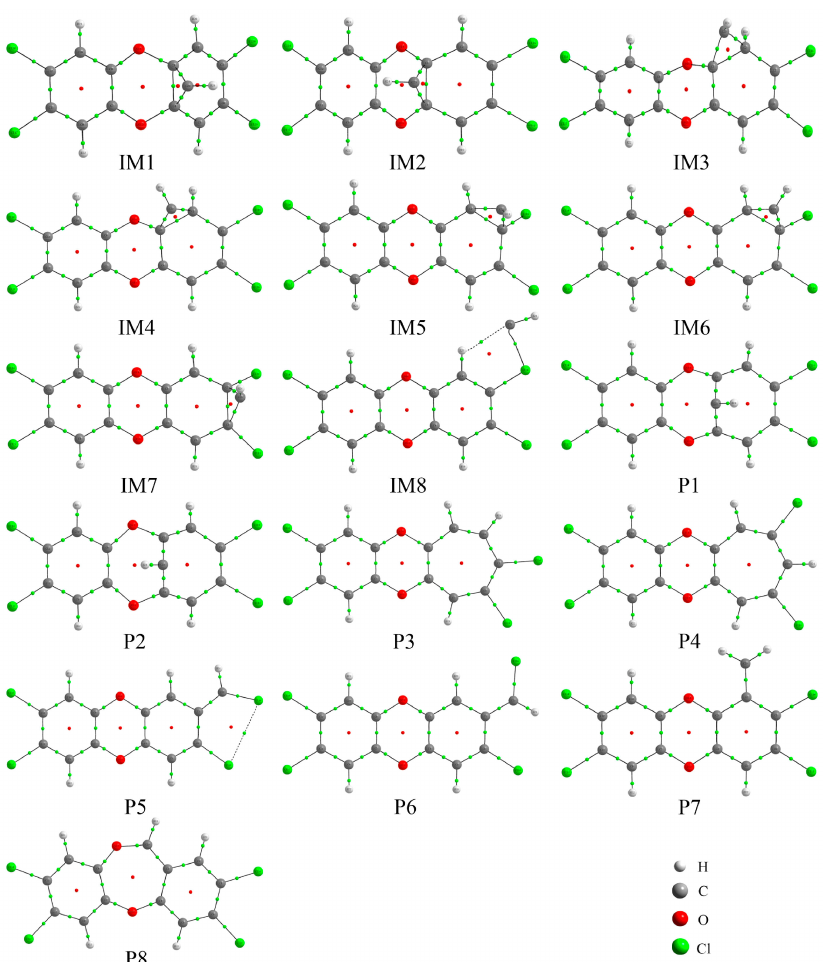
Figure 3. Molecular graphs of the initial intermediates and products, where the BCP and RCP are denoted as small green and red dots,